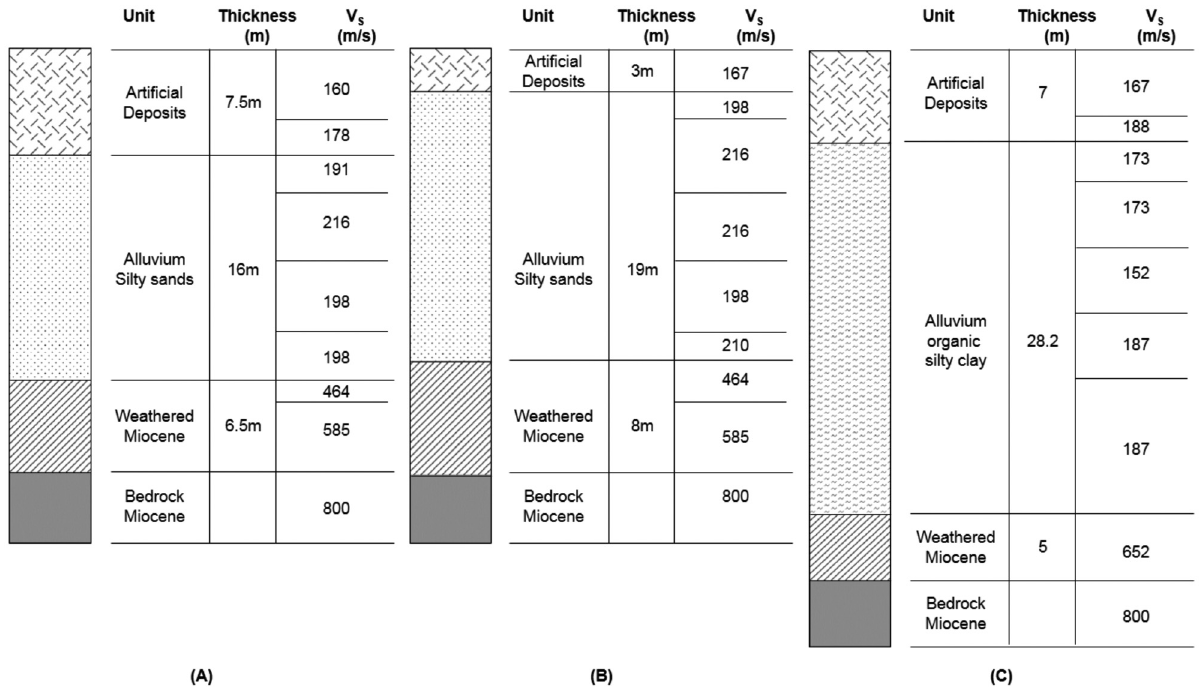
values: (A) S5; (B) S9; (C) (S32) S